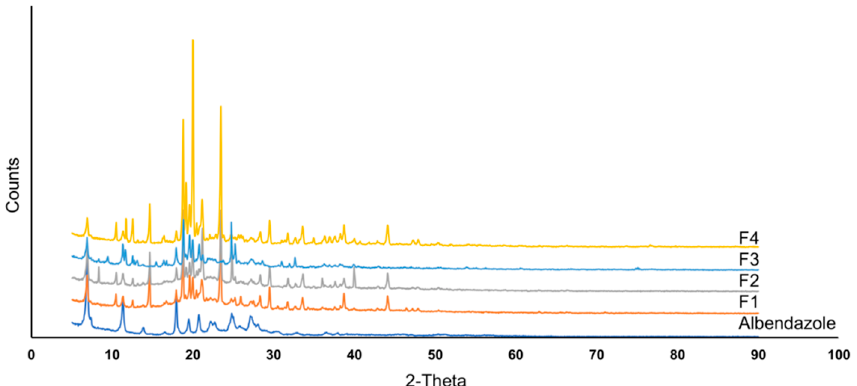
Figure 6. X ‐ ray diffractogram of albendazole and albendazole self ‐ microemulsifying chewable tablets Figure 6. X-ray diffractogram of albendazole and albendazole self-microemulsifying chewable tablets formulation F1 – F4. formulation